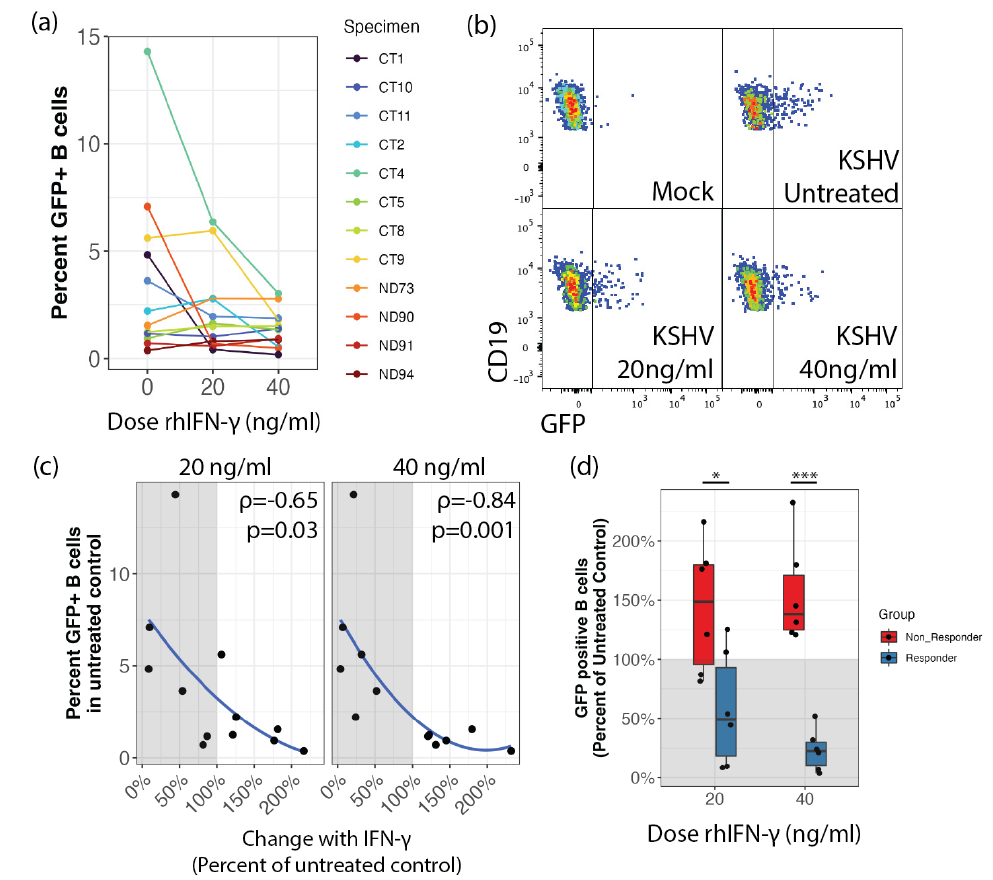
Figure 1. IFN- γ inhibition of KSHV infection in B cells is restricted to susceptible tonsil-derived lymphocyte specimens. B cells derived from 12 unique tonsil specimens were infected with KSHV and cultured in a reconstituted total lymphocyte environment with the indicated doses of IFN- γ . At 3dpi cells were analyzed for KSHV infection by flow cytometry. ( a ) the percentage of GFP+ cells within the viable CD19+ B cell population. ( b ) representative flow cytometry data showing decreased viable/CD19+/GFP+ cells in response to IFN- γ treatment ( c ) monotonic relationship between GFP+ cells in untreated control (specimen susceptibility) and the per-specimen change in GFP+ B cells with IFN- γ treatment. Spearman rank correlation coefficients and p-values for each dose are indicated on the respective panels. ( d ) analysis of grouped differences between responder/susceptible (blue) and non-responder/refractory (red) specimens at indicated doses of IFN- γ represented as a percent of untreated control with grey shading indicating decreased relative values. Wilcoxon rank sum test p -values * =0.04; *** =0.002. Table 1. Lineage definitions for lymphocyte subsets used in the study.